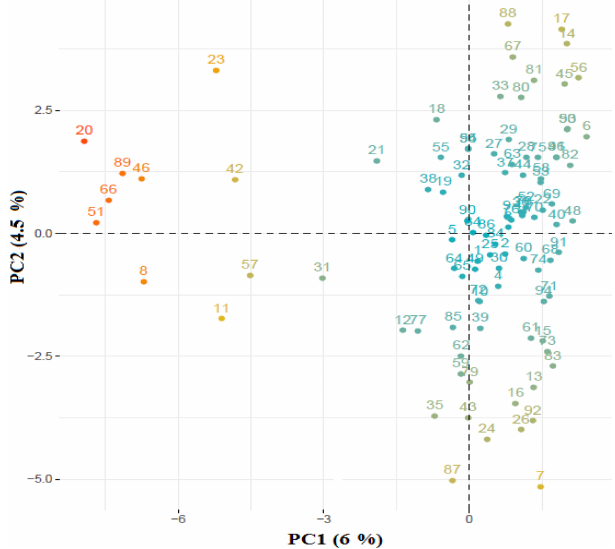
Figure 1. PCA plot based on a genomic relationship matrix. The first two principal components (PCs) and the variance explained by each component is shown on the corresponding axis. The amount of variance explained by the first two components is relatively small (10.5%), representing a great deal of genetic diversity among sam-